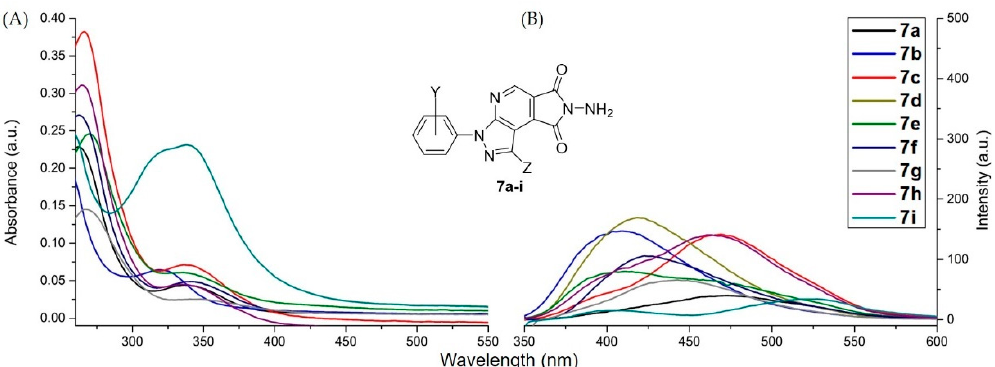
Figure 6. Photoluminescence spectra of N -aminopyrazolopyrrolopyridine diones 7a – i dissolved in DMSO to prepare a stock solution (1.0 mM). Then the stock solutions were diluted with CH 2 Cl 2 to a concentration of 10 μ M. ( A ) Absorption and ( B ) emission spectra of compounds 7a – i .